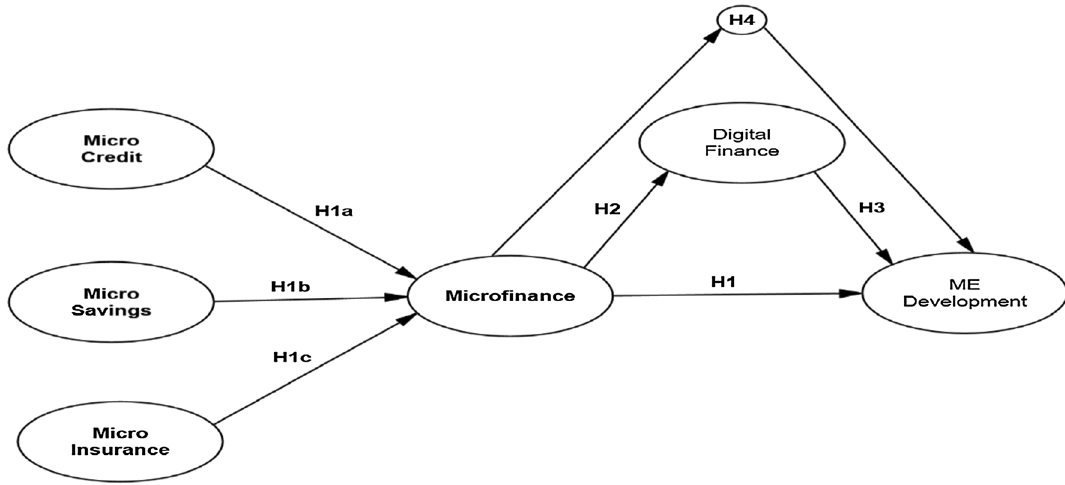
Fig. 1 Conceptual